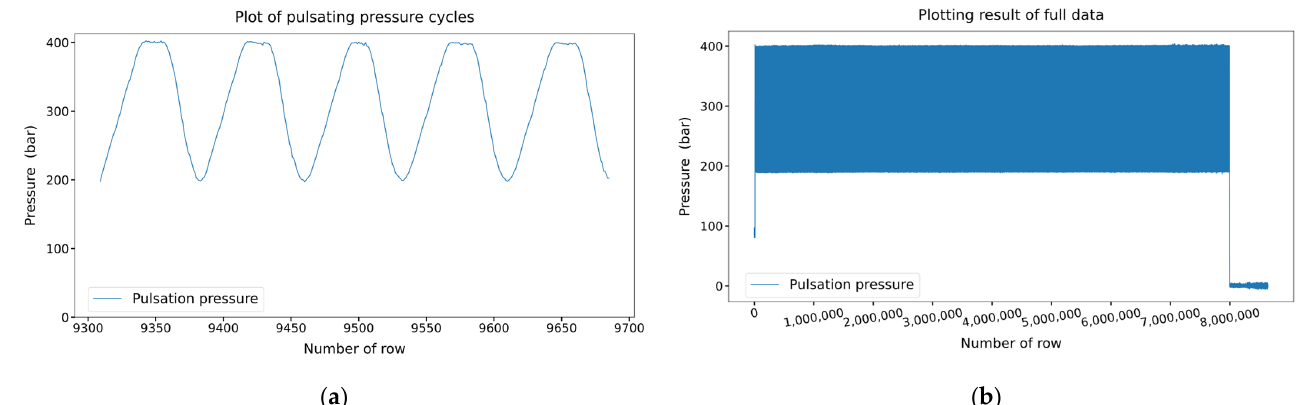
Figure 4. Visualization of pulsating pressure. ( a ) Visualization of five pulsating pressure cycles; ( b ) visualization of the complete data of the pulsating